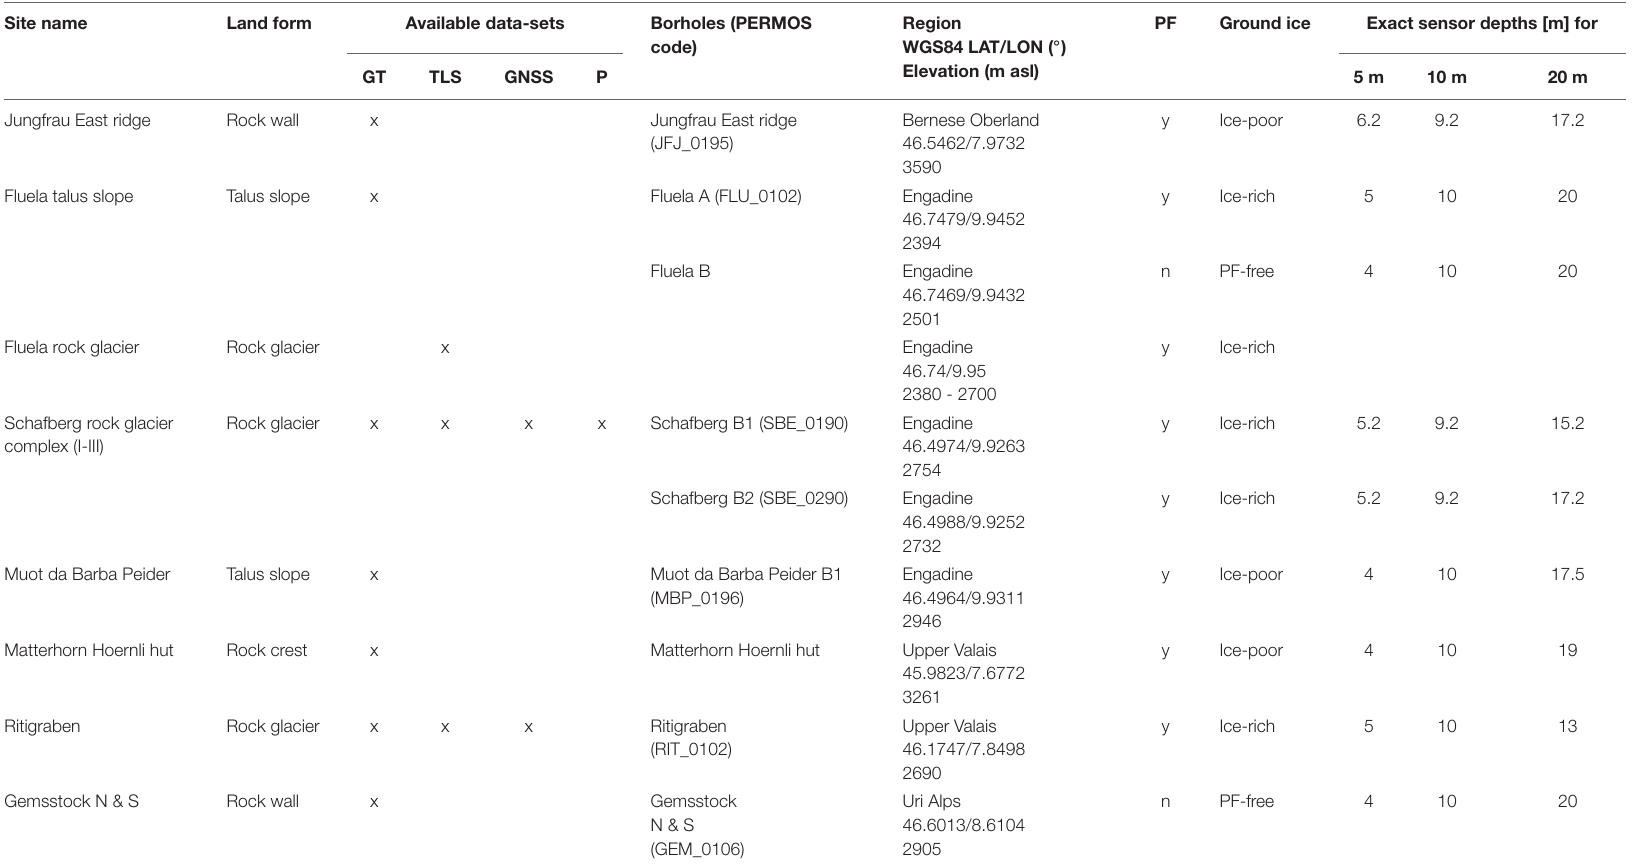
TABLE 1 | Overview of the sites and data presented. The measurement methods carried out at each site are indicated with an “x.” The analyses of ground temperatures are based on measurements at depths around 5, 10, and 20 m. Here, the exact sensor depths are given. Abbreviations used: GT, ground temperature; PF, permafrost; y, yes; n, no; P, photogrammetry; N, north-west; S,